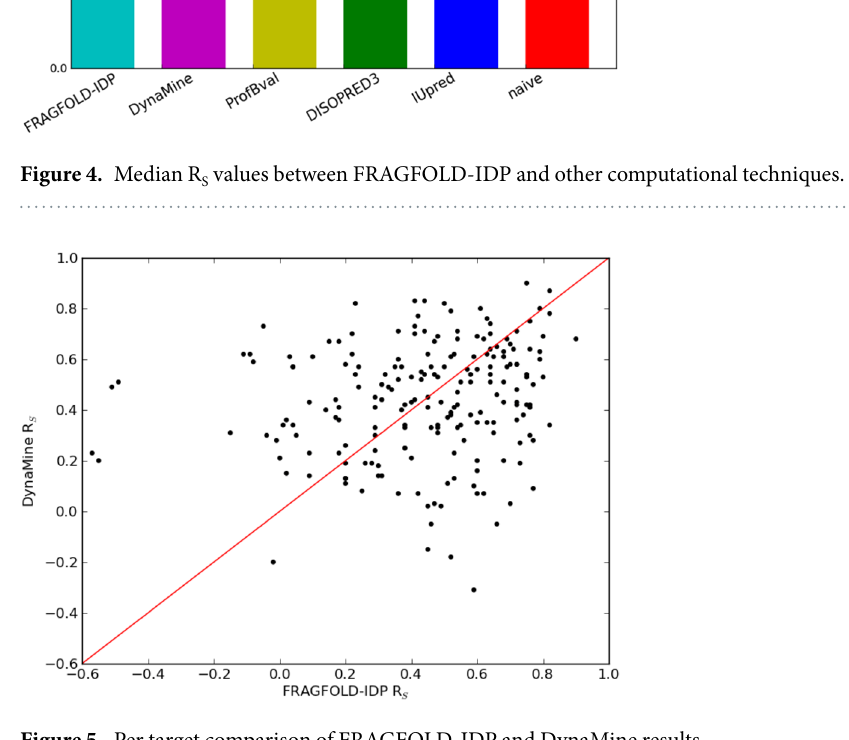
Figure 5. Per target comparison of FRAGFOLD-IDP and DynaMine